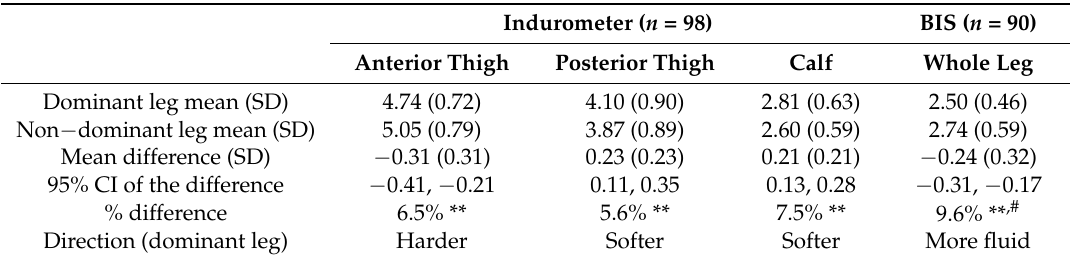
Table 4. Mean values and between-leg differences using the Indurometer and